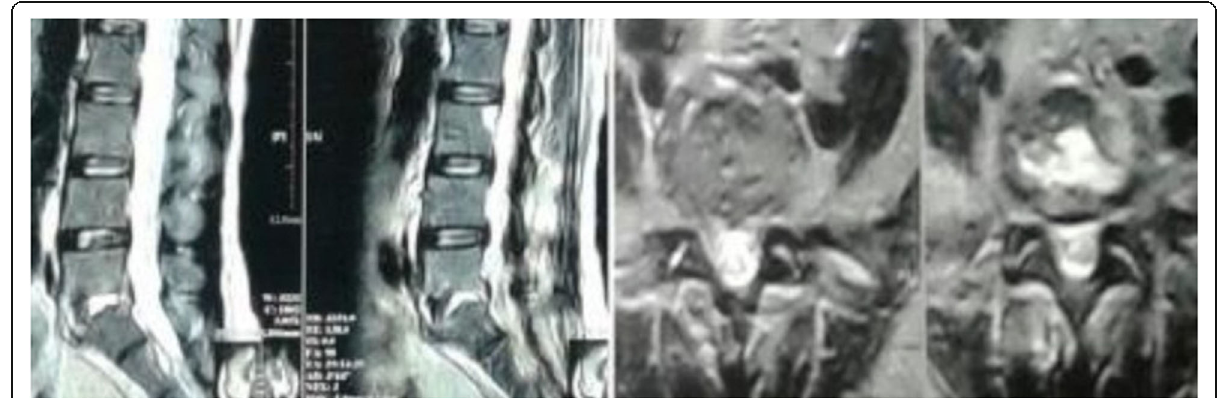
Fig. 1 T2-weighted MRI of a 43-year-old male presenting with spontaneous L5/S1 discitis. Operated upon by debridement and fusion, showed